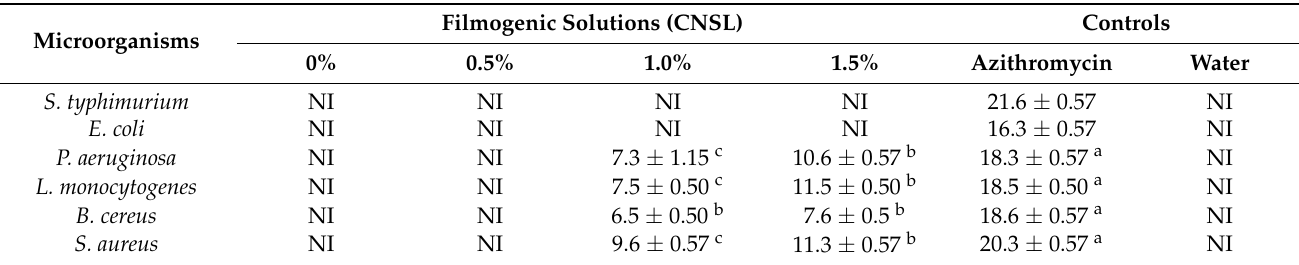
Table 3. Antimicrobial activity of bioactive films obtained from the incorporation of cashew nut shell liquid (CNSL) into a matrix of sodium alginate in different concentrations using the well diffusion agar method expressed as inhibition area diameter (mm).